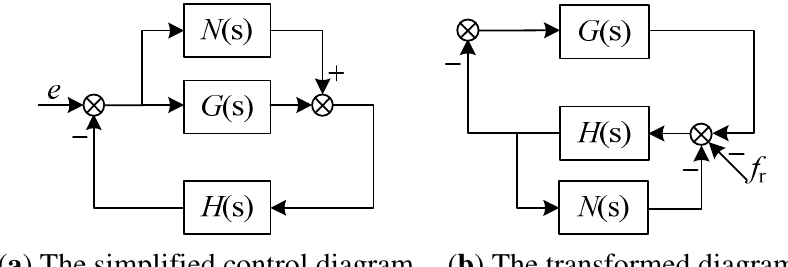
( a ) The simplified control diagram ( b ) The transformed